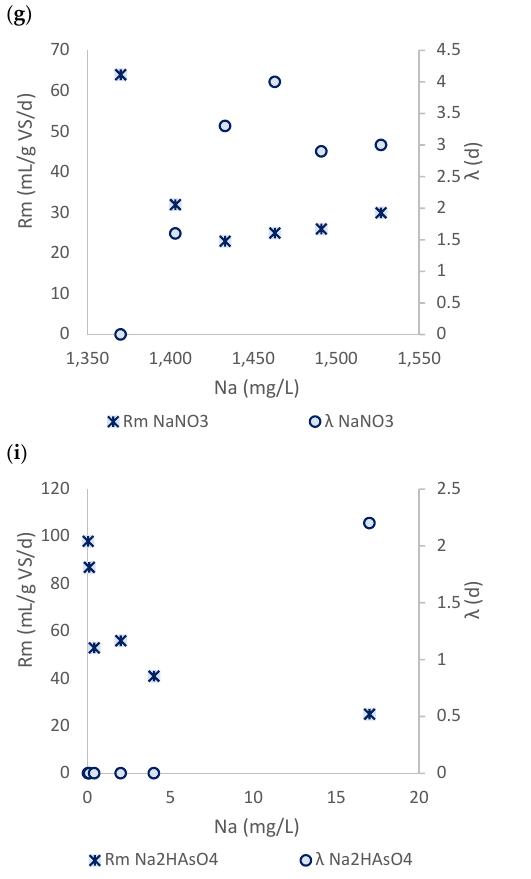
mg N/L of TAN of ammonium sulphate, 150 mL biogas/g VS/d, than in the ammonium chloride experiment, 98 mL biogas/g VS/d, at 586 mg/L of TAN (Figure 5). Therefore, de-